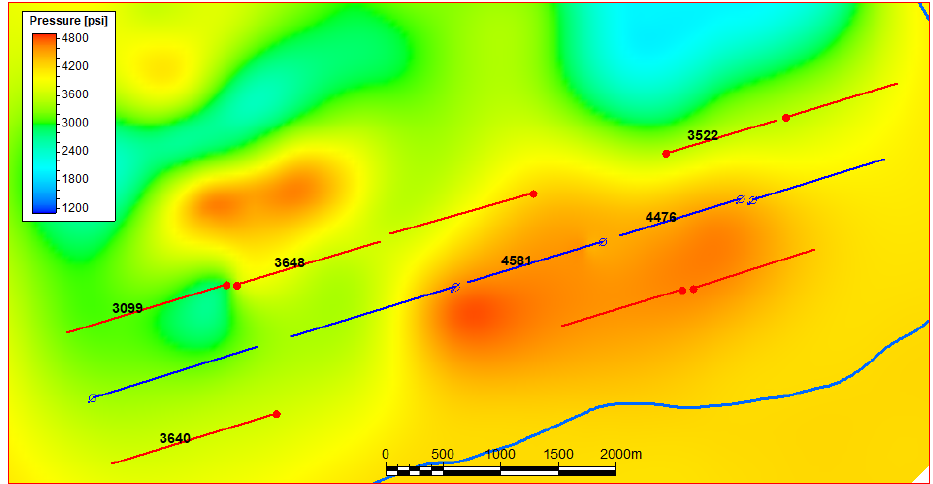
Figure 23. Pressure distribution map of injection ‐ production horizontal well pattern.